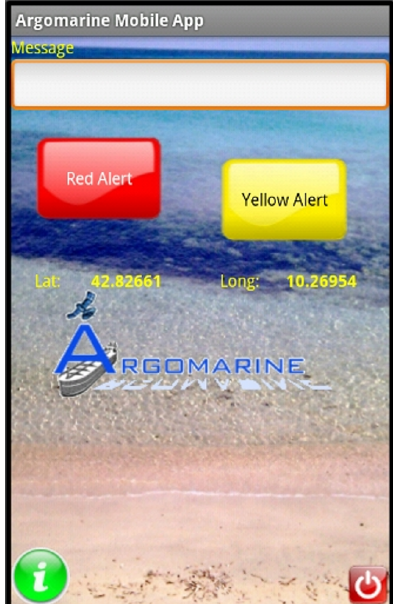
Figure 2. The main screen of the ARGO Sentinel, available at Google Play.